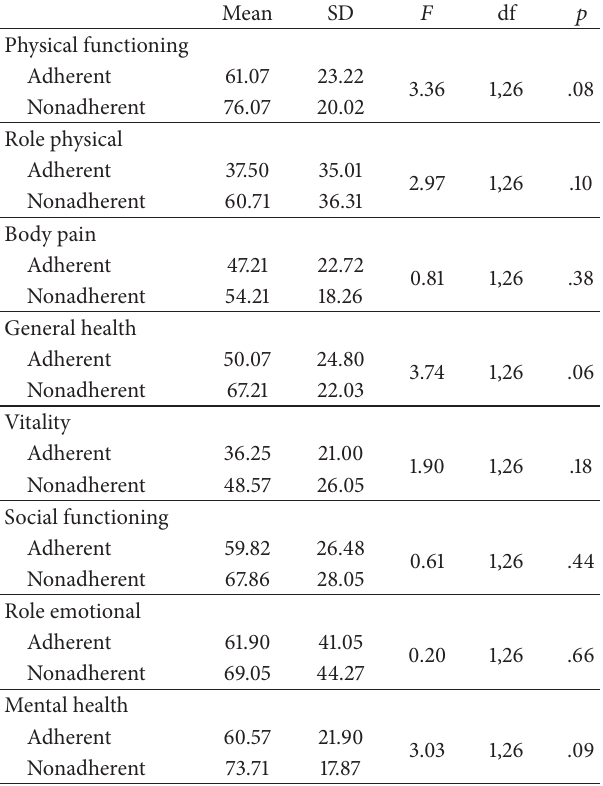
Table 4: Health-related quality of life scores for adherent and nonadherent participants.